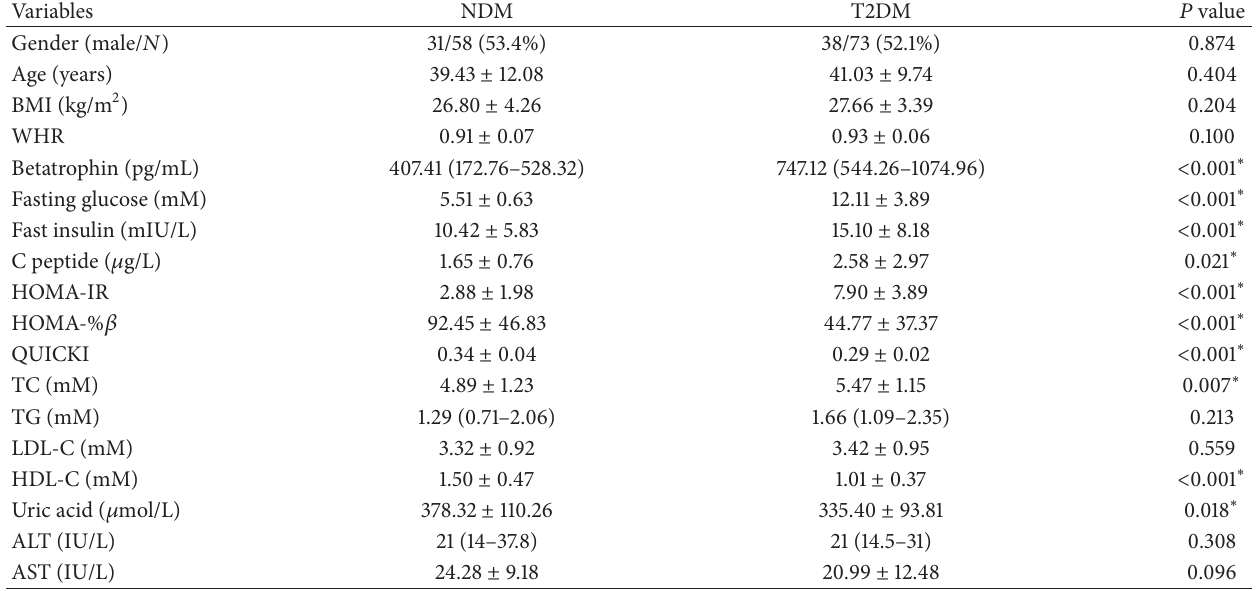
Table 1: General characteristics of normal glucose participants and newly diagnosed T2DM